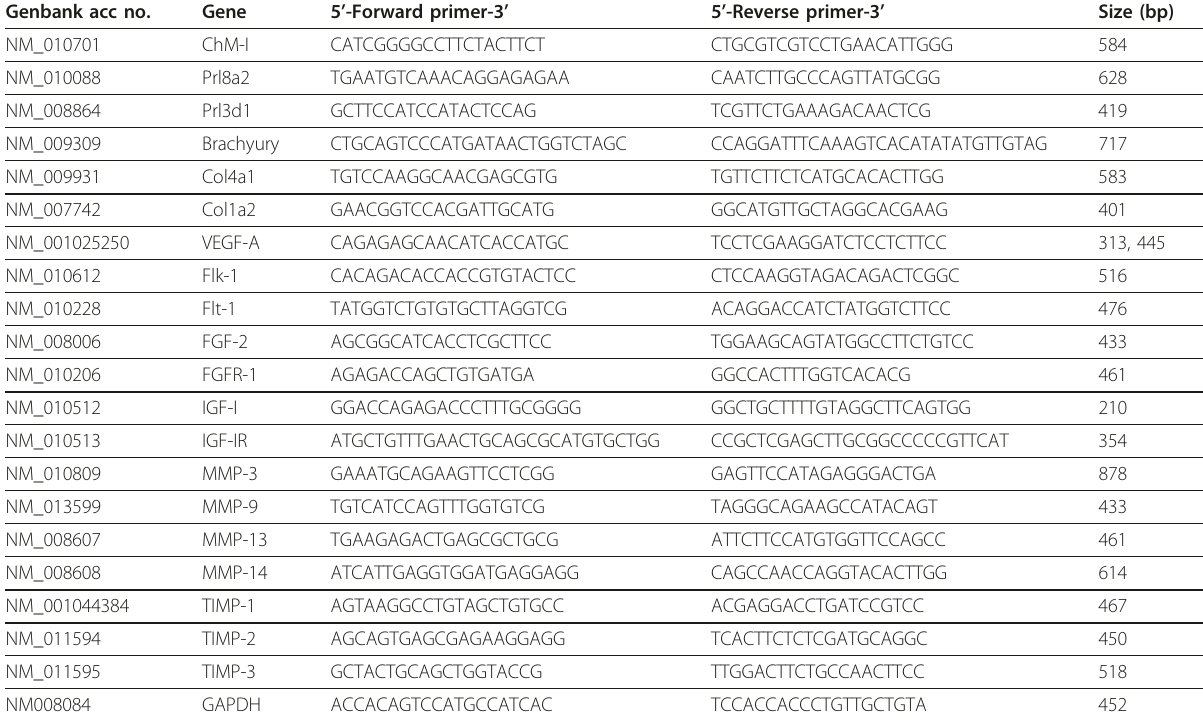
Table 1 Primers for RT-PCR analysis Genbank acc